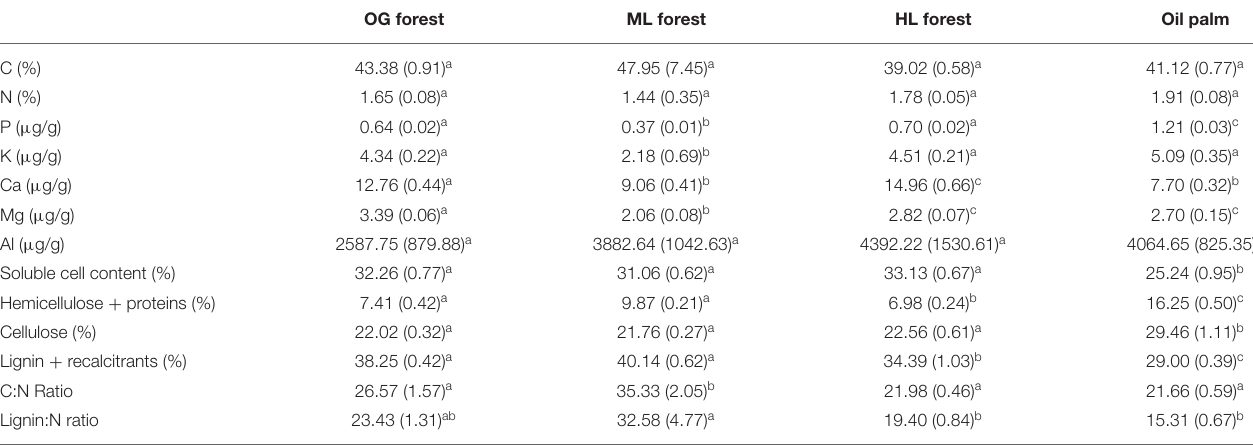
TABLE 1 | Chemical properties of autoclaved litter mixtures taken from old growth (OG) forest, moderate logged (ML) forest, heavily logged (HL) forest, and oil palm plantation. OG forest ML forest